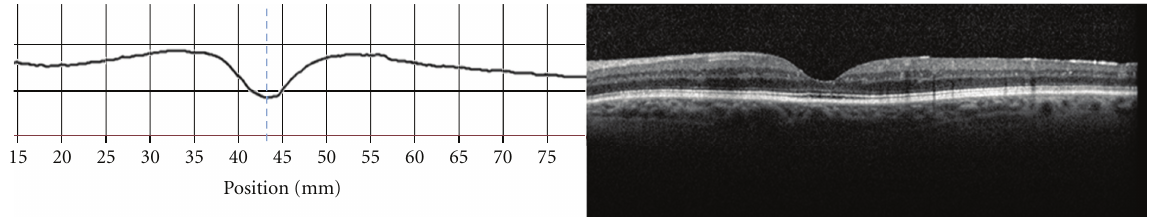
Figure 7: Premacular hole configuration SD-OCT (right) and foveal thickness graph (left) illustrating steep and asymmetrical slopes.